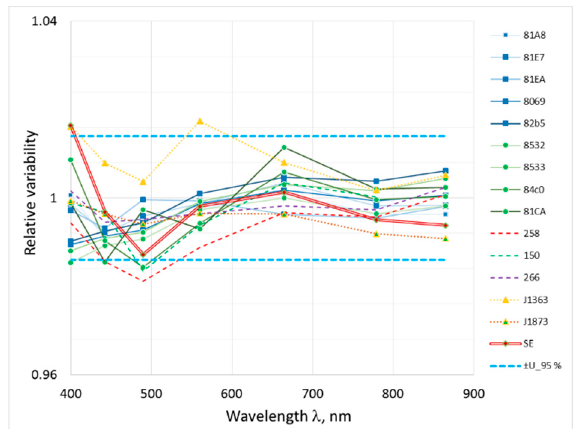
Figure 8. Irradiance sensors; agreement with reference values of the filter radiometer. Blue dashed lines—expanded uncertainty covering 95% of all data points. Uncertainty of radiometric calibration is